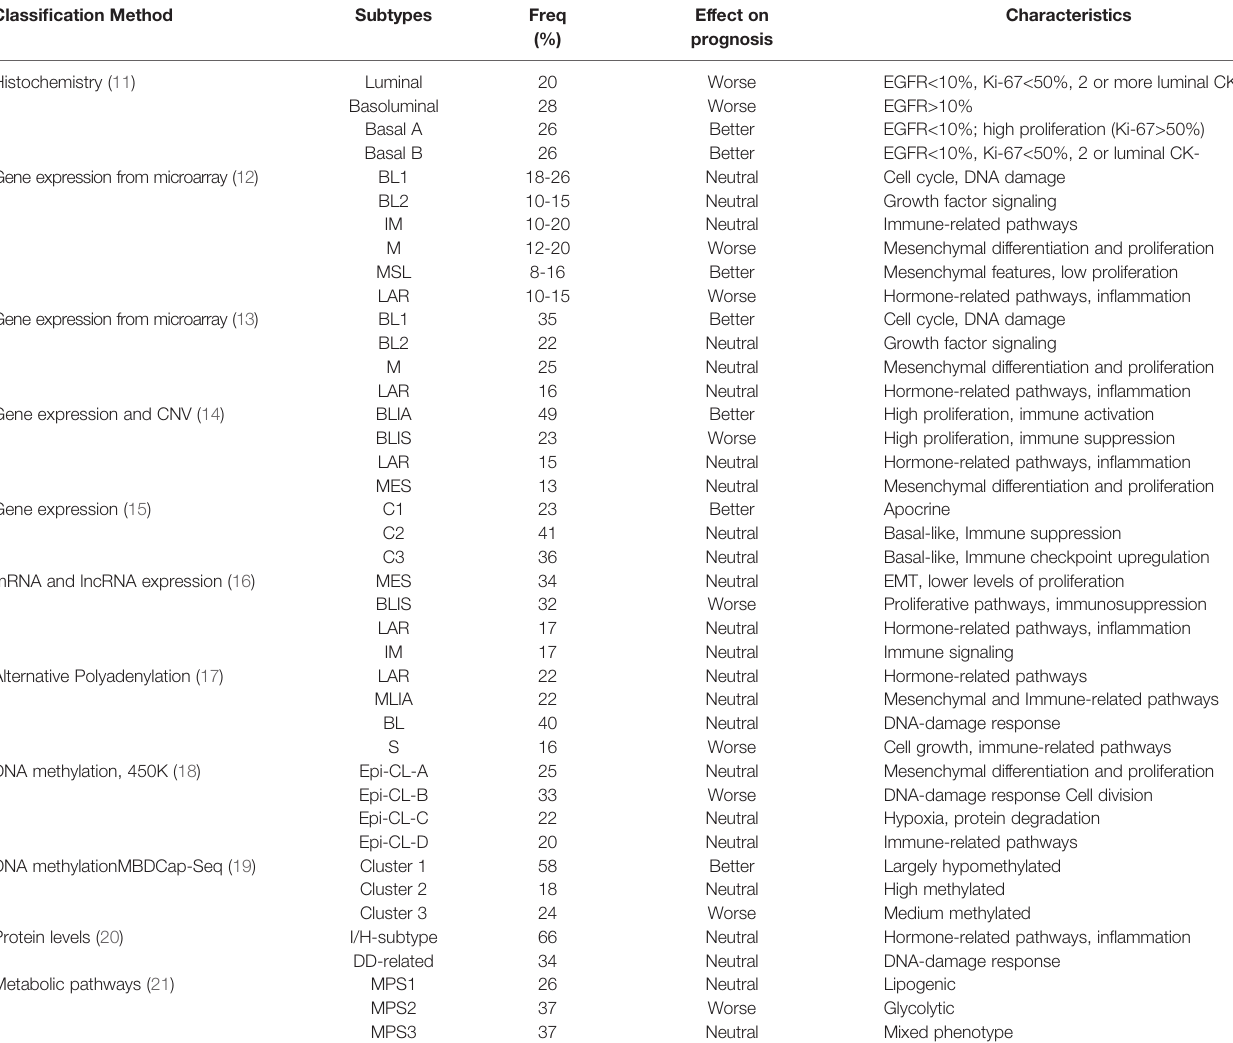
TABLE 1 | Examples of TNBC strati fi cation